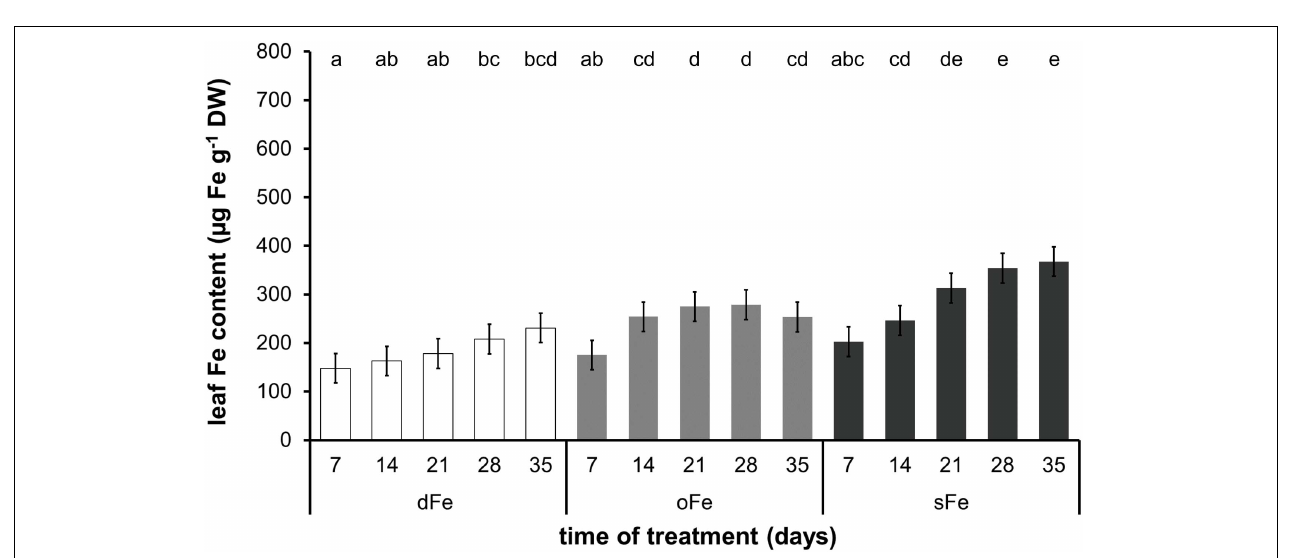
FIGURE 2 | Fe content of the 4th leaves of plants grown on deficient (dFe), optimal (oFe), and supraoptimal (sFe) Fe supply, represented by open, light grey and dark grey columns, respectively, on a dry weight (DW) basis of leaves. Error bars represent SD values. To compare the differences, one-way ANOVA was performed with Tukey–Kramer post hoc test on the treatments [ P < 0.05; n = 3 × 3 (biological × technical)].